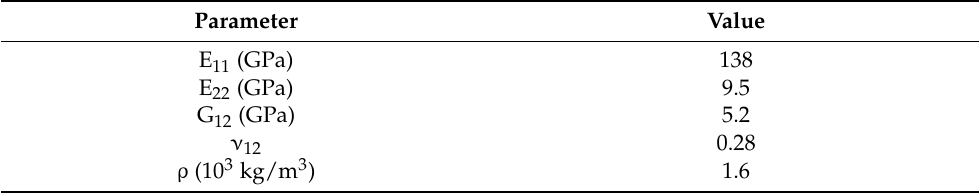
Figure 8. As a demonstration example, a simple quadratic shell with a center hole and a shear load case is examined. The deformed geometry is illustrated by the dotted line. Table 1. Material properties of each unidirectional carbon/epoxy composite ply.